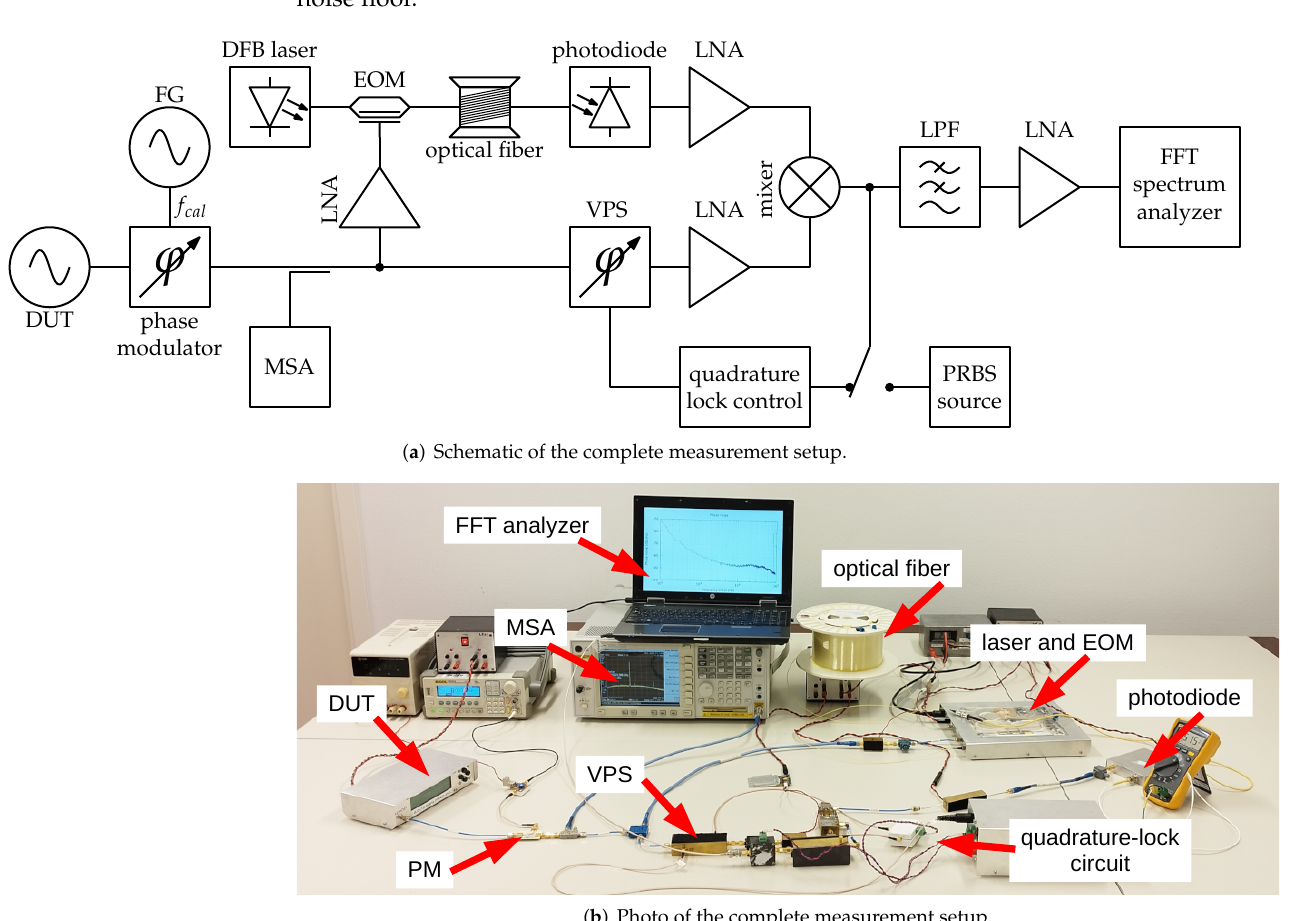
Figure 5. Complete measurement